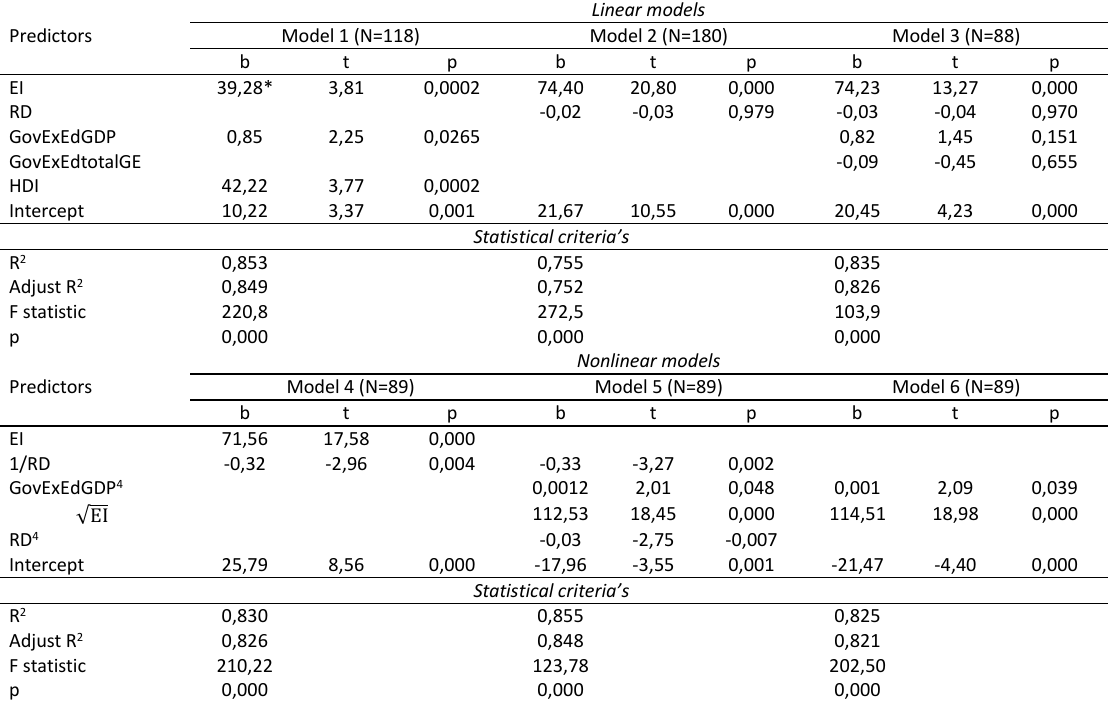
Table 3: Linear and nonlinear multivariate regression modeling (dependent variable – EPI) Predictors